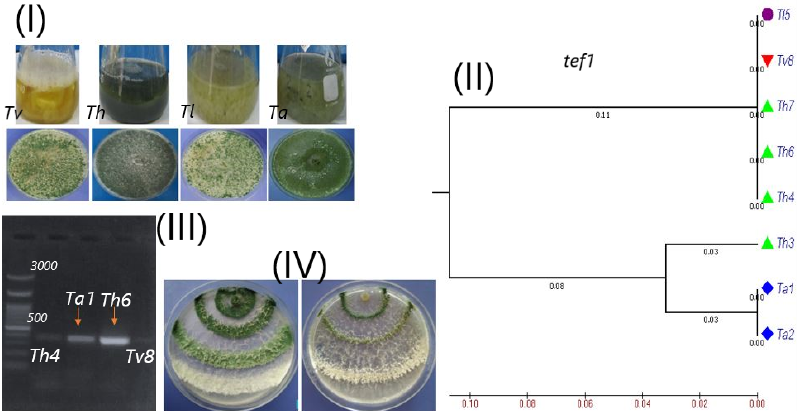
Figure 1. (I) Trichoderma species used in this study. (II) Phylogenetic tree of the identified isolates based on the TEF1 sequences dataset. The numbers below the Figure 1. ( I ) Trichoderma species used in this study. ( II ) Phylogenetic tree of the identified isolates branches indicate bootstrap values. (III) Calmodulin gene ( cal ) detection in the strains with the highest ( Ta1, Th6 ) and the lowest ( Th4, Tv8 ) growth rate test. (IV) The growth rate of Trichoderma strains on different growth media. Ta1 = Trichoderma asperlum; Ta 2 = Trichoderma asperlum; Th3 = Trichoderma harzianum; Th4 = based on the TEF1 sequences dataset. The numbers below the branches indicate bootstrap values. ( III ) Calmodulin gene ( cal ) detection in the strains with the highest ( Ta1 , Th6 ) and the lowest ( Th4 , Tv8 ) growth rate test. ( IV ) The growth rate of Trichoderma strains on di ff erent growth media. Ta1 = Trichoderma asperlum ; Ta2 = Trichoderma asperlum ; Th3 = Trichoderma harzianum ; Th4 = Trichoderma harzianum ; Tl5 = Trichoderma longibrachiatum ; Th6 = Trichoderma harzianum ; Th7 = Trichoderma harzianum ; Tv8 = Trichoderma viride